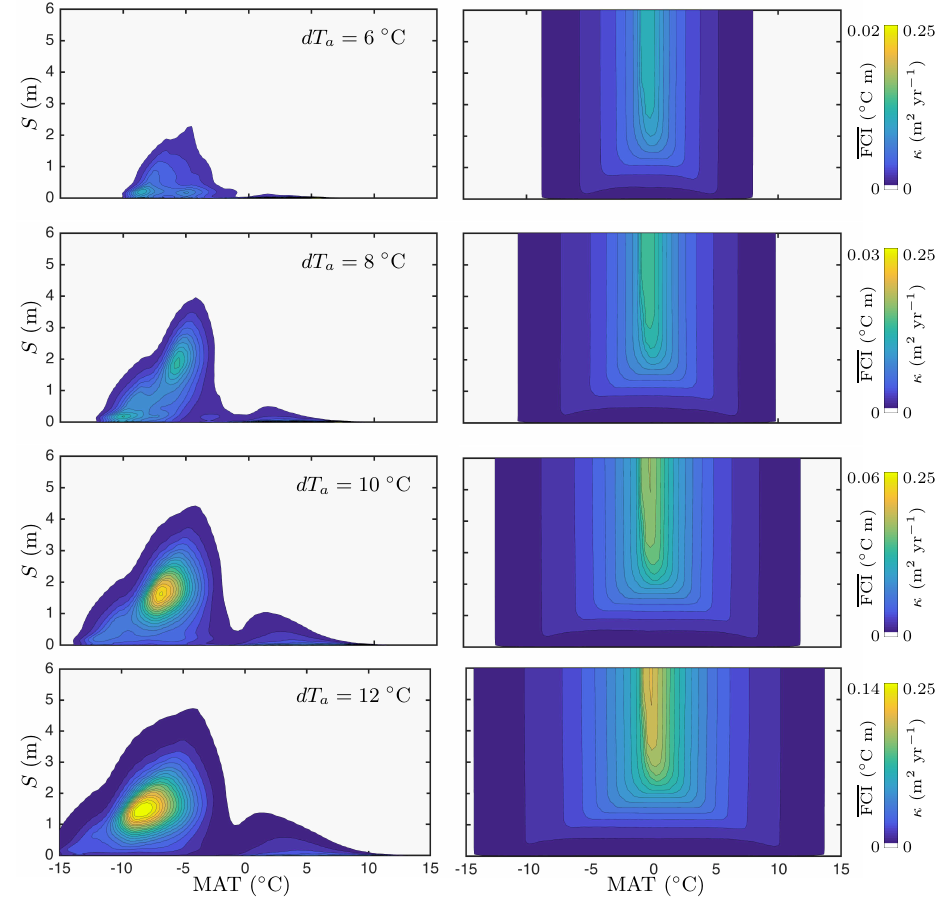
Figure 9. The effect of the amplitude of the annual temperature variation, d T a , on frost cracking (left) and frost creep (right). Note that the colour scale for FCI varies between situations with different d T a